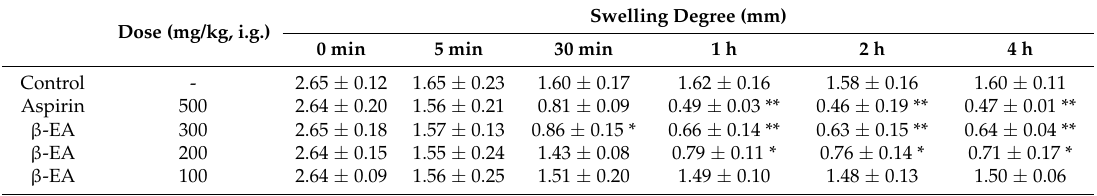
Table 4. Effect of β -EA on carrageenin-induced paw edema in mice ( n = 10). Dose (mg/kg, i.g.)